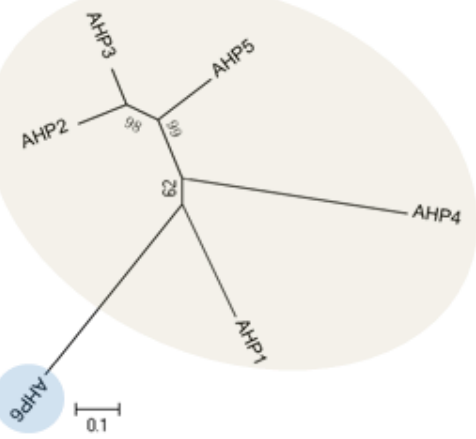
Figure 4. Phylogenetic relationship of histidine-containing phosphotransfer proteins (HPts) in Arabidopsis .